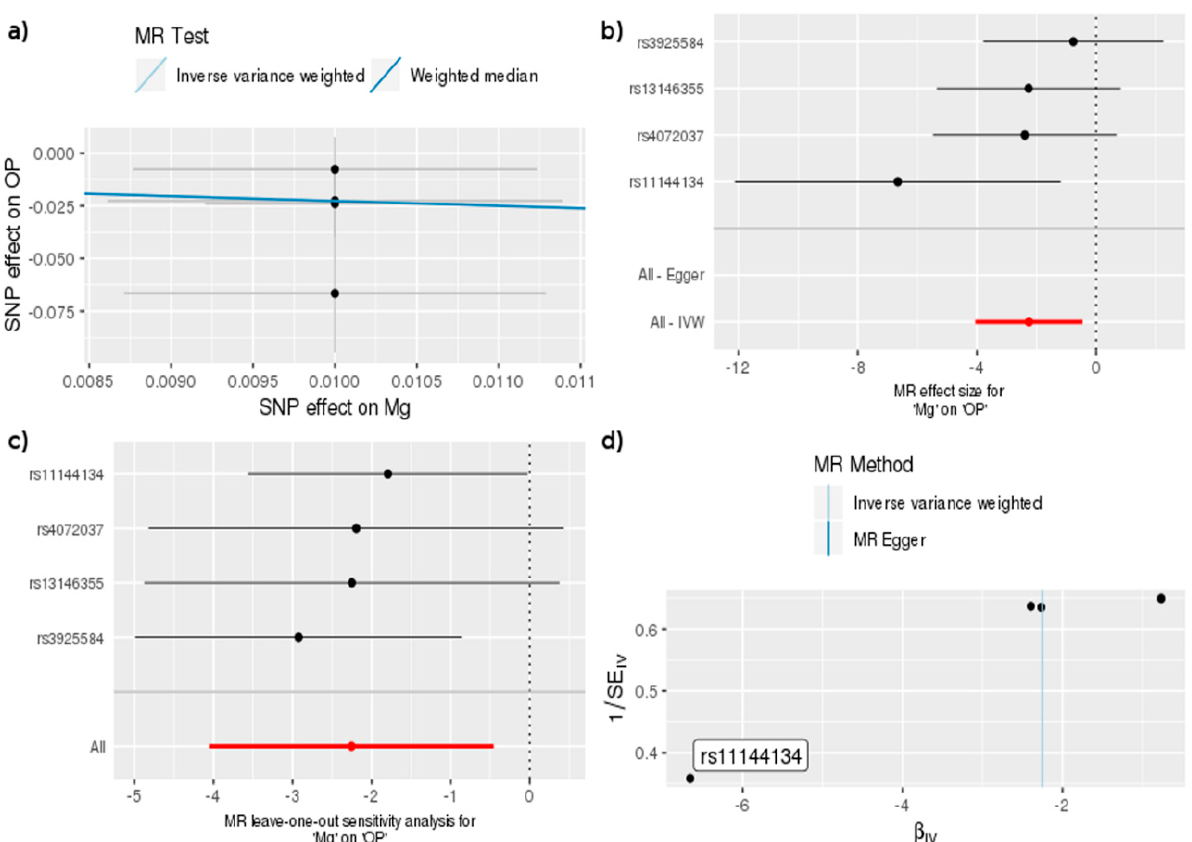
Figure 2. MR study of Mg and OP: ( a ) A graph that correlates the effect size of the SNP-Mg association (x-axis, SD units) and the SNP-OP association (y-axis, log OR) to the standard error bars. The slope of the line corresponds to a causal estimate using a different method. ( b ) The forest map, where each black dot represents a single SNP as IV, shows the logarithm of the odds ratio (OR) per standard deviation (SD) under the influence of mineral magnesium; the red dot shows the use of the IVW results for all SNPs; the horizontal line indicates the 95% confidence interval. ( c ) The leave-one-out method sensitivity analysis. Each black dot represents an IVW method for estimating the causal effect of the Mg element on OP and does not exclude a case where a particular SNP causes a significant change in the overall result. ( d ) The funnel plot shows the estimation using the inverse of the standard error of the causal estimate using each individual SNP as a tool. The vertical line shows the results of the IVW method using all SNPs.